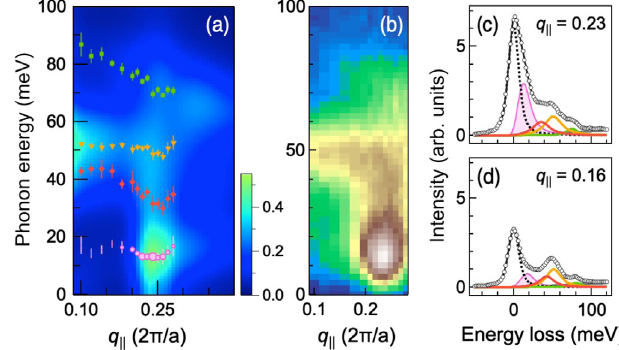
FIG. 4. Phonon excitations from RIXS measurements of optimally doped LSCO. (a) Calculated intensity distribution map using the diagrammatic framework in comparison with phonon dispersions obtained from RIXS spectra of 24 K. Green squares, orange triangles, and red diamonds depict the disper- sions of BS, A 1 , and B 1 phonon modes, respectively. The g g dispersions of the low-energy RIXS excitations are represented by pink circles scaled to the fitted intensity. (b) RIXS intensity distribution map of T ¼ 24 K extracted from Fig. 2(b) and plotted with the same color scale. (c),(d) Measured RIXS spectra FIG. 3. Temperature dependence of CDW fluctuations. with fitted components for phonon excitations of momenta q k ¼ (a) Momentum-integrated RIXS spectra after the subtraction of 0 . 23 and 0.16 at T ¼ 24 K, respectively. The curve fitting scheme elasticscattering andthenmomentumintegrationover arangefrom is the same as that in Fig. 3(a). RIXS data are plotted as open 0.22 to 0.25 in units of 2 π =a at different temperatures. The RIXS circles with black curves to show the summation of fitted spectra are fitted to four phonon modes. The component derived components and a linear background. The component derived from the coupling of CDW fluctuations to acoustic phonons is from the coupling of CDW fluctuations to acoustic and optical shaded in pink. The components of the BS, A 1 , and B 1 phonon phonons is shaded in pink. The components of the BS, A 1 , and g g g modes are shown in green, orange, and red, respectively. Details of B 1 phonon modes are shown in green, orange, and red, g the curve fitting are presented in Supplemental Material [47]. respectively. The elastic component is plotted as a dashed (b) RIXS peak intensity of the 14-meV component shown in (a), ; ω Þ after con- compared to the maximum of calculated S ð q CDW ; ω Þ volution with the instrumental resolution. Thevalue of S ð q CDW withthe 24-KdatapointisnormalizedtotheRIXSintensity.Values ; ω Þ calculations are plotted in of Δ and Γ used for the S ð q CDW CDW (c)and (d), respectively. (d)Temperaturedependenceof Γ . The CDW gray dashed line indicates the slope of the lifetime width vs T determined by the limit of the Planckian dissipation. All solid lines connecting data points in (b) – (d) serve as visual guidance.